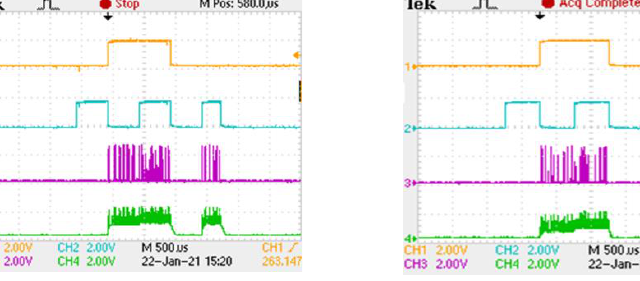
Figure 9. Test results of the Pavlov SNN chip (from left to right: TID 300 krad (Si), 500 krad (Si), 1